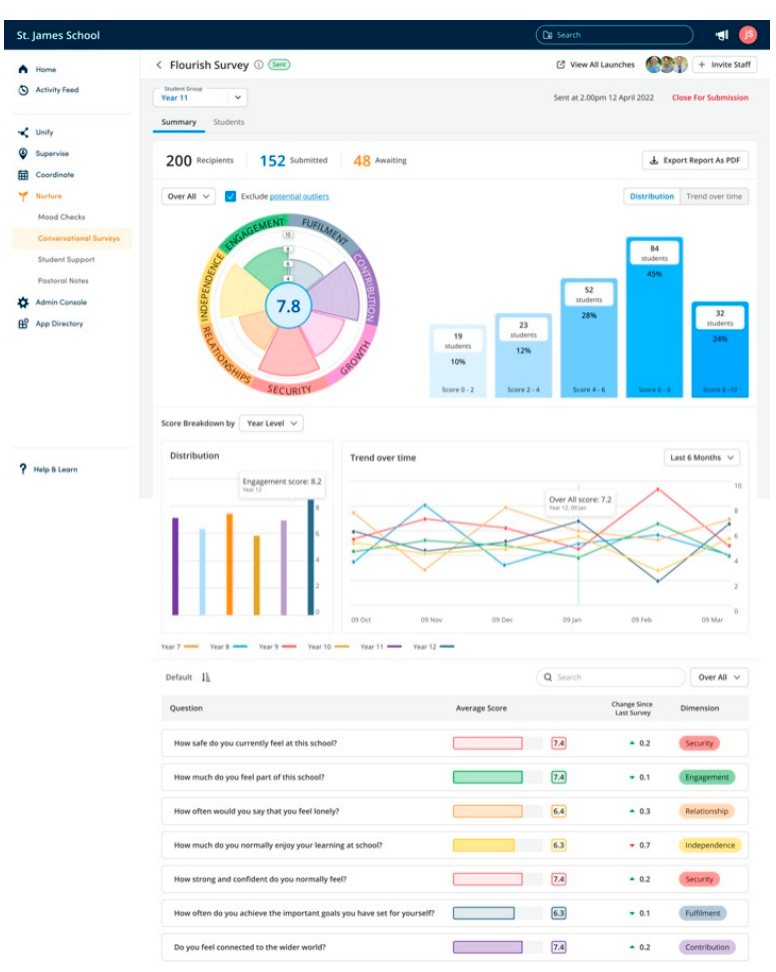
Figure 9. Flourish Survey Report—Nurture Beta Web Platform.